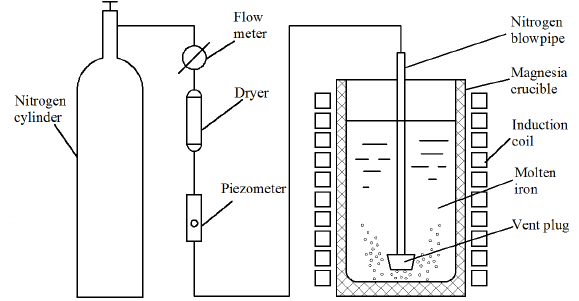
Figure 1. Schematic diagram of high-nitrogen DI, manufactured by injecting nitrogen gas.